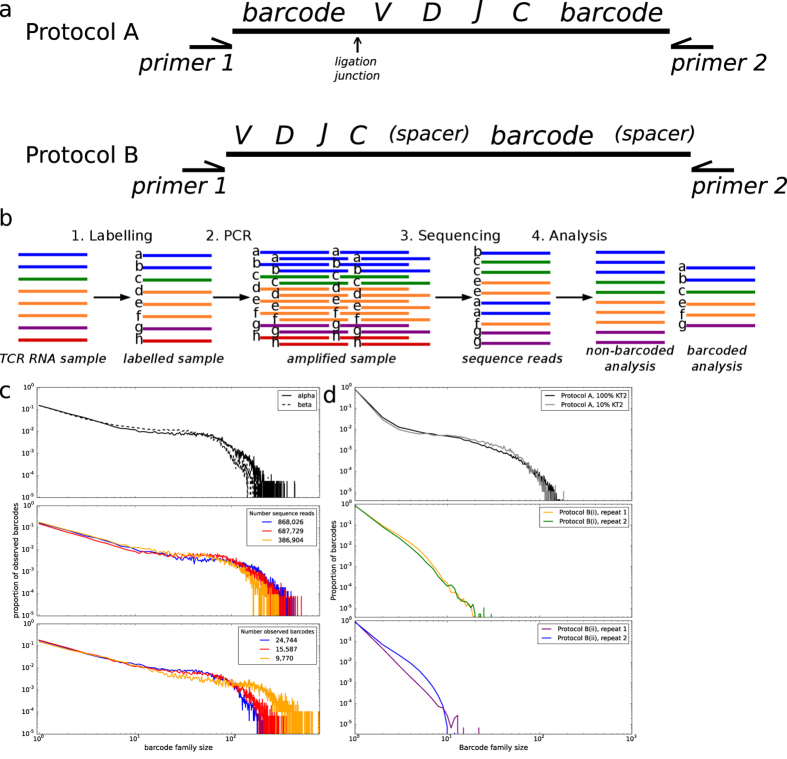
(a) Schematic of the target TCR molecule in Protocols A and B showing the position of the barcode for molecular identification and the PCR priming sites. In the T cell receptor portion of the molecule, V, D, J and C refer to the Variable, Diversity (β chain only), Joining and Constant regions (not to scale). The two alternative possible positions for the barcodes in protocol B(i) and B(ii) are shown in brackets. The Illumina sequencing primers, indices to allow for multiplexing of samples, and the Illumina adaptor sequences are not shown. (b) Schematic of experimental and computational protocol used to sequence and analyse TCRs from isolated RNA. Barcodes (represented here by lower case letters) are included in each TCR molecule together with a known sequence (SP2). PCR is then performed to amplify the sample. The amplified pool of molecules is diluted and introduced to the sequencer, where a sample of molecules will adhere to the flow cell and be sequenced. Repertoire analysis is performed on the sequencing data, with the barcodes allowing correction of biased PCR amplification as well as correction of sequencing errors. (c) The distribution of observed barcode family size (the number of reads occurring in the sequencer output that originate from the same initial target molecule in the sample) in polyclonal TCR sequence data (Protocol A) from healthy volunteer T cells. Upper: TCR alpha chain (solid line) and beta chain (dotted line) data. Middle: TCR repertoires sequenced at different depths Bottom: TCR repertoires with different numbers of observed barcodes, representing the number of initial molecules. (d) The observed barcode family size distribution observed in TCR sequence data from a sample of RNA isolated from a T cell clone (KT2, responding to tetanus toxoid27). Upper: TCR alpha chain (solid line) and beta chain (dashed line) from protocol A. Middle: TCR beta chain data from protocol B, using the oligonucleotide with 6 bp spacer between the sequencing primer and the barcode. Bottom: TCR beta chain data from protocol B, using the oligonucleotide with the barcode directly next to the sequencing primer.